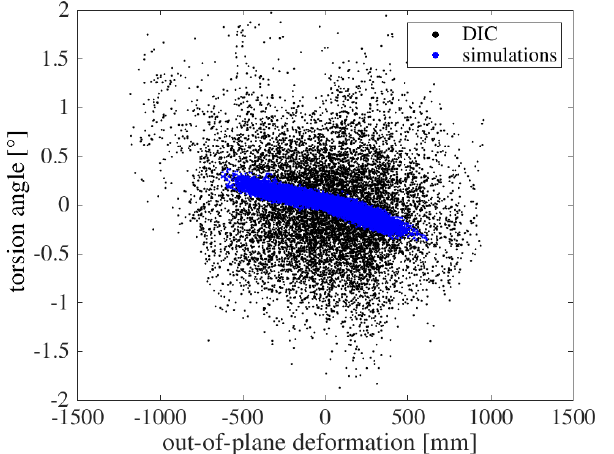
Figure 24. Simulated pitch + torsion angle of simulation no. 1 of all blades.